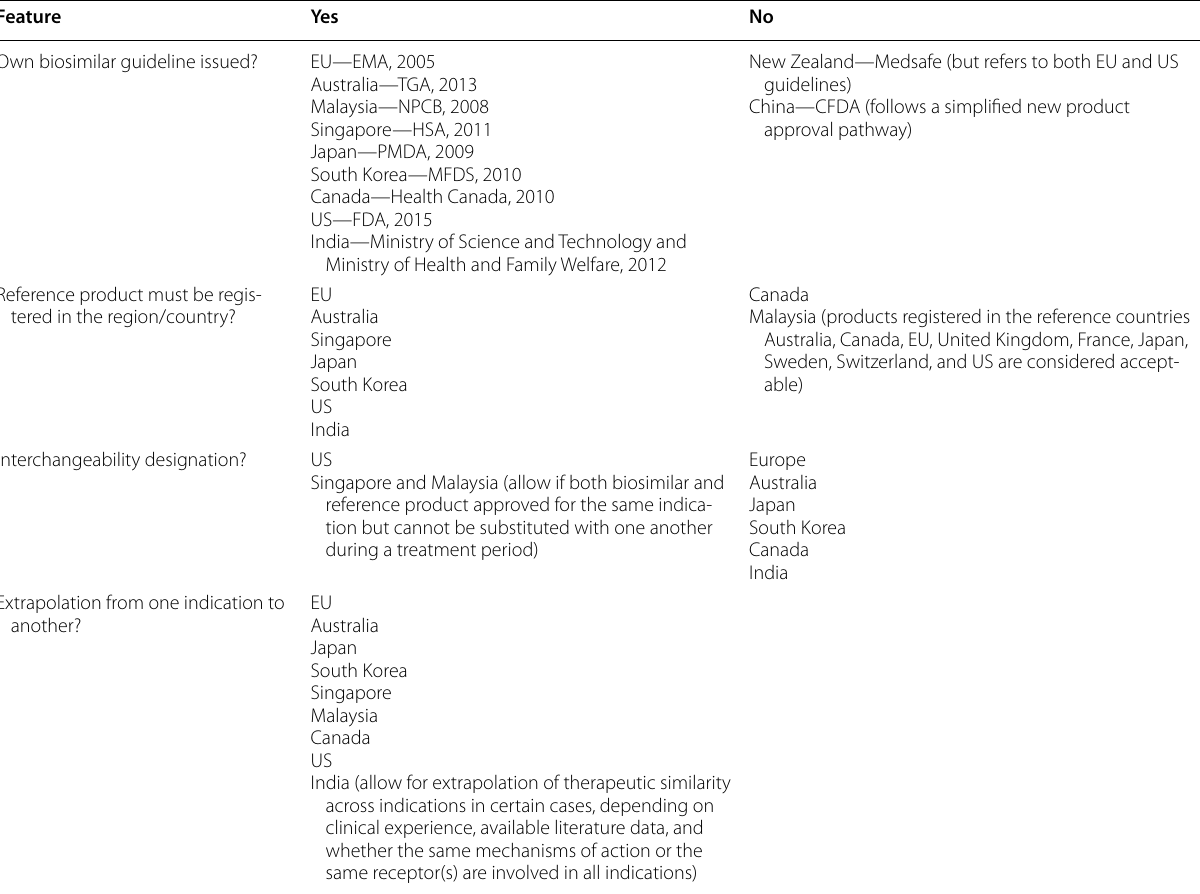
EU the European Union; EMA the European Medicines Agency; TGA the Therapeutic Goods Administration; CDE the Center for Drug Evaluation; NPCB the National Pharmaceutical Control Bureau; HSA the Health Sciences Authority; PMDA the Pharmaceuticals and Medical Devices Agency; MFDS the Ministry of Food and Drug Safety; US the United States; FDA the Food and Drug Administration; Medsafe the Medical Devices Safety Authority; CFDA the China Food and Drug